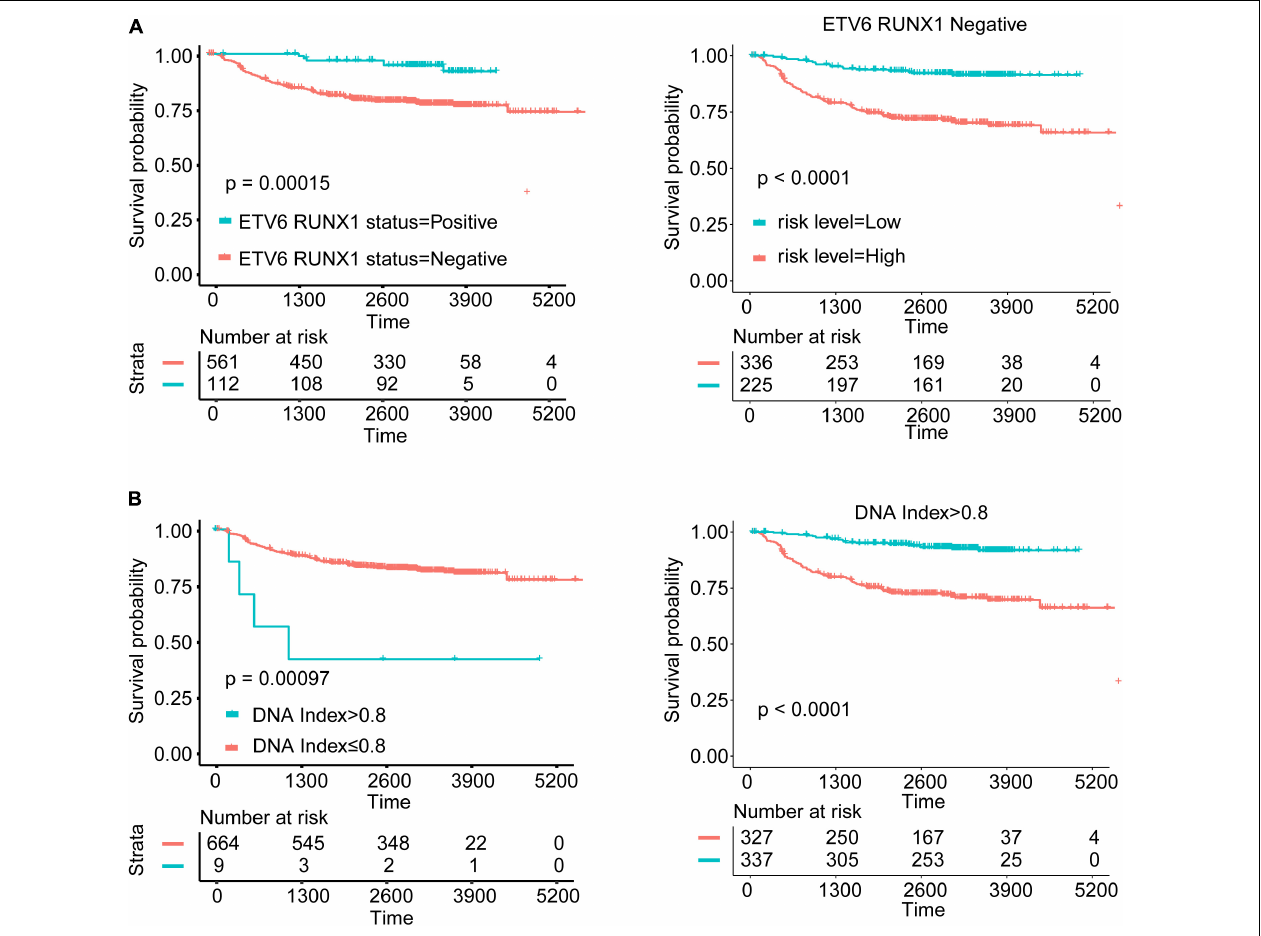
FIGURE 5 | Survival analysis for subgroups according to variable in nomogram. (A) Kaplan–Meier curves of ETV6 RUNX1 fusion status and comparison of the survival outcomes between the high- and low-risk groups in different ETV6 RUNX1 fusion gene status. (B) Kaplan–Meier curves of DNA index status and comparison of the survival outcomes between the high- and low-risk groups in different DNA index